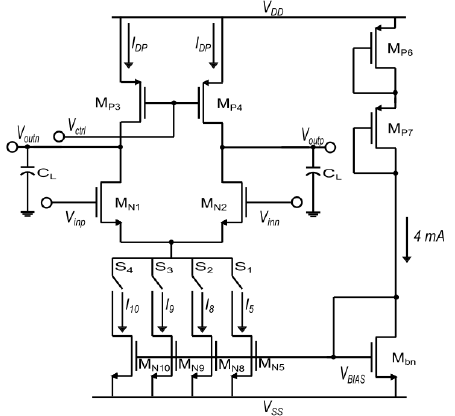
Figure 12. Programmable tail currents in the CMOS differential stage using four